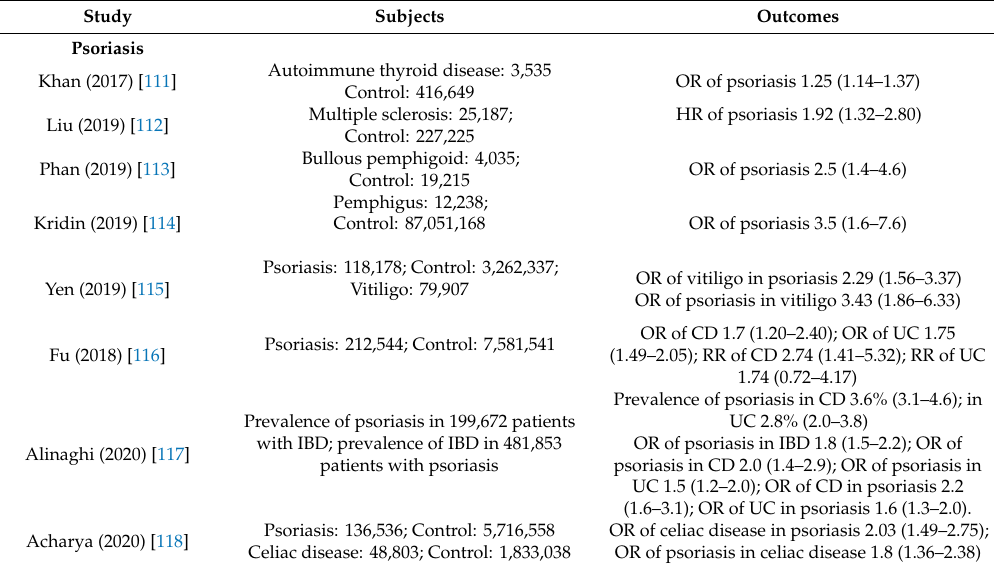
Table 5. Summary of the systematic review and meta-analyses identifying the association of psoriasis and psoriatic arthritis with various autoimmune